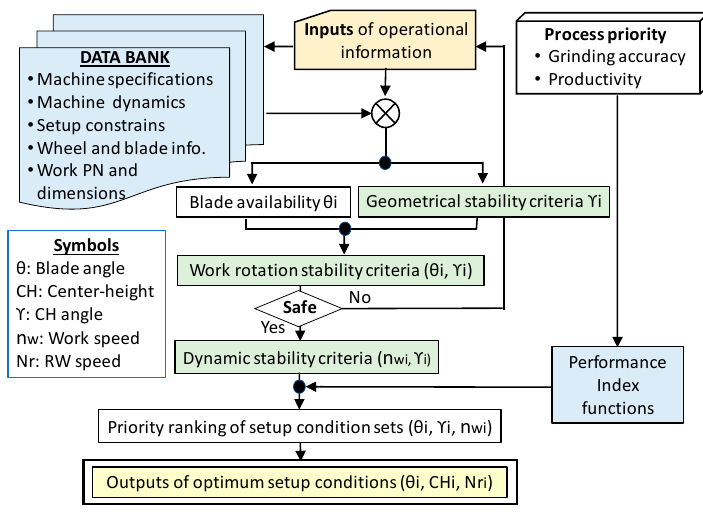
Figure 19. Flow chart of developed model “Opt-Setup Master”.